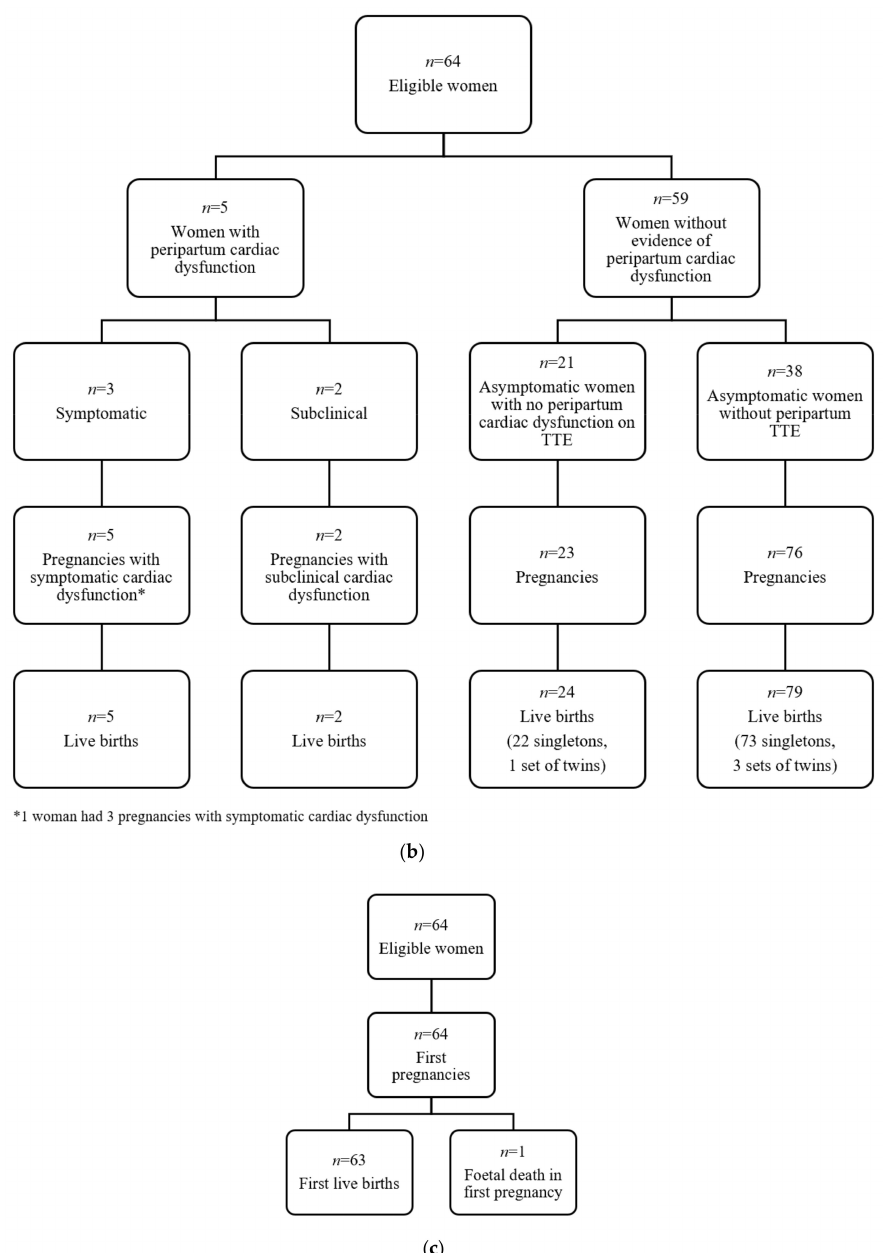
Figure 1. Patient eligibility. ( a ) Per “live birth” ( n = 110); ( b ) Per “patient” ( n = 64); ( c ) Per “first live birth” ( n =